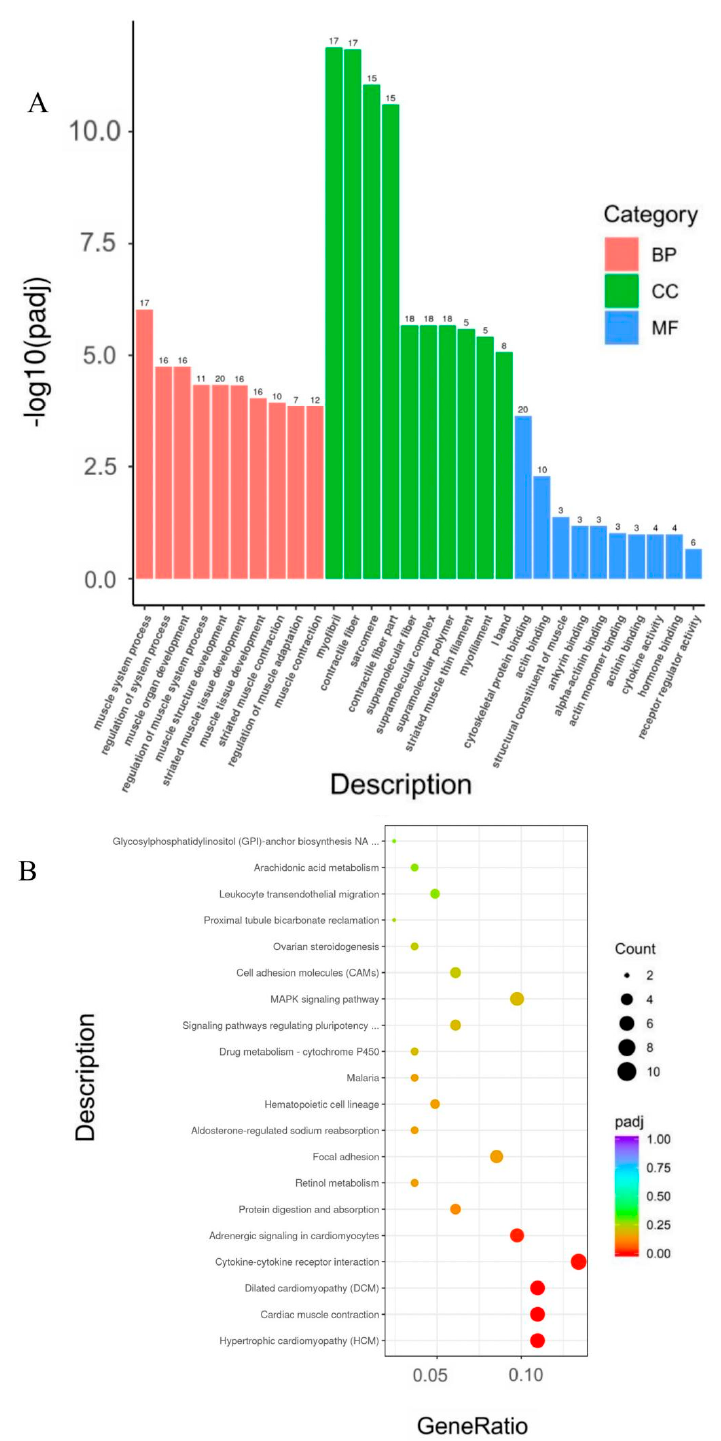
Figure 4. GO and KEGG pathway analyses of DEGs. ( A ) Gene ontology (GO) enrichment of DEGs. FDR ≤ 0.05 is considered significantly enriched. ( B ) Bubble chart of KEGG − function − enrichment analysis of DEGs. Abscissa is ratio of number of DEGs annotated to KEGG pathway to total number of DEGs. Ordinate is KEGG pathway. The KEGG node containing upregulated gene is marked in red. The KEGG node containing downregulated gene is marked in green. The KEGG node containing up − and downregulated gene is marked in yellow.